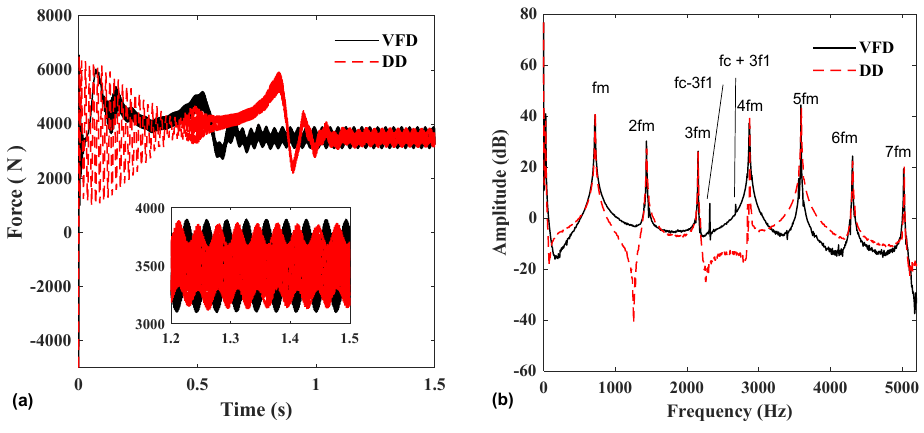
Figure 15. Gear1 − 3 mesh force: ( a ) time domain and ( b ) frequency domain.